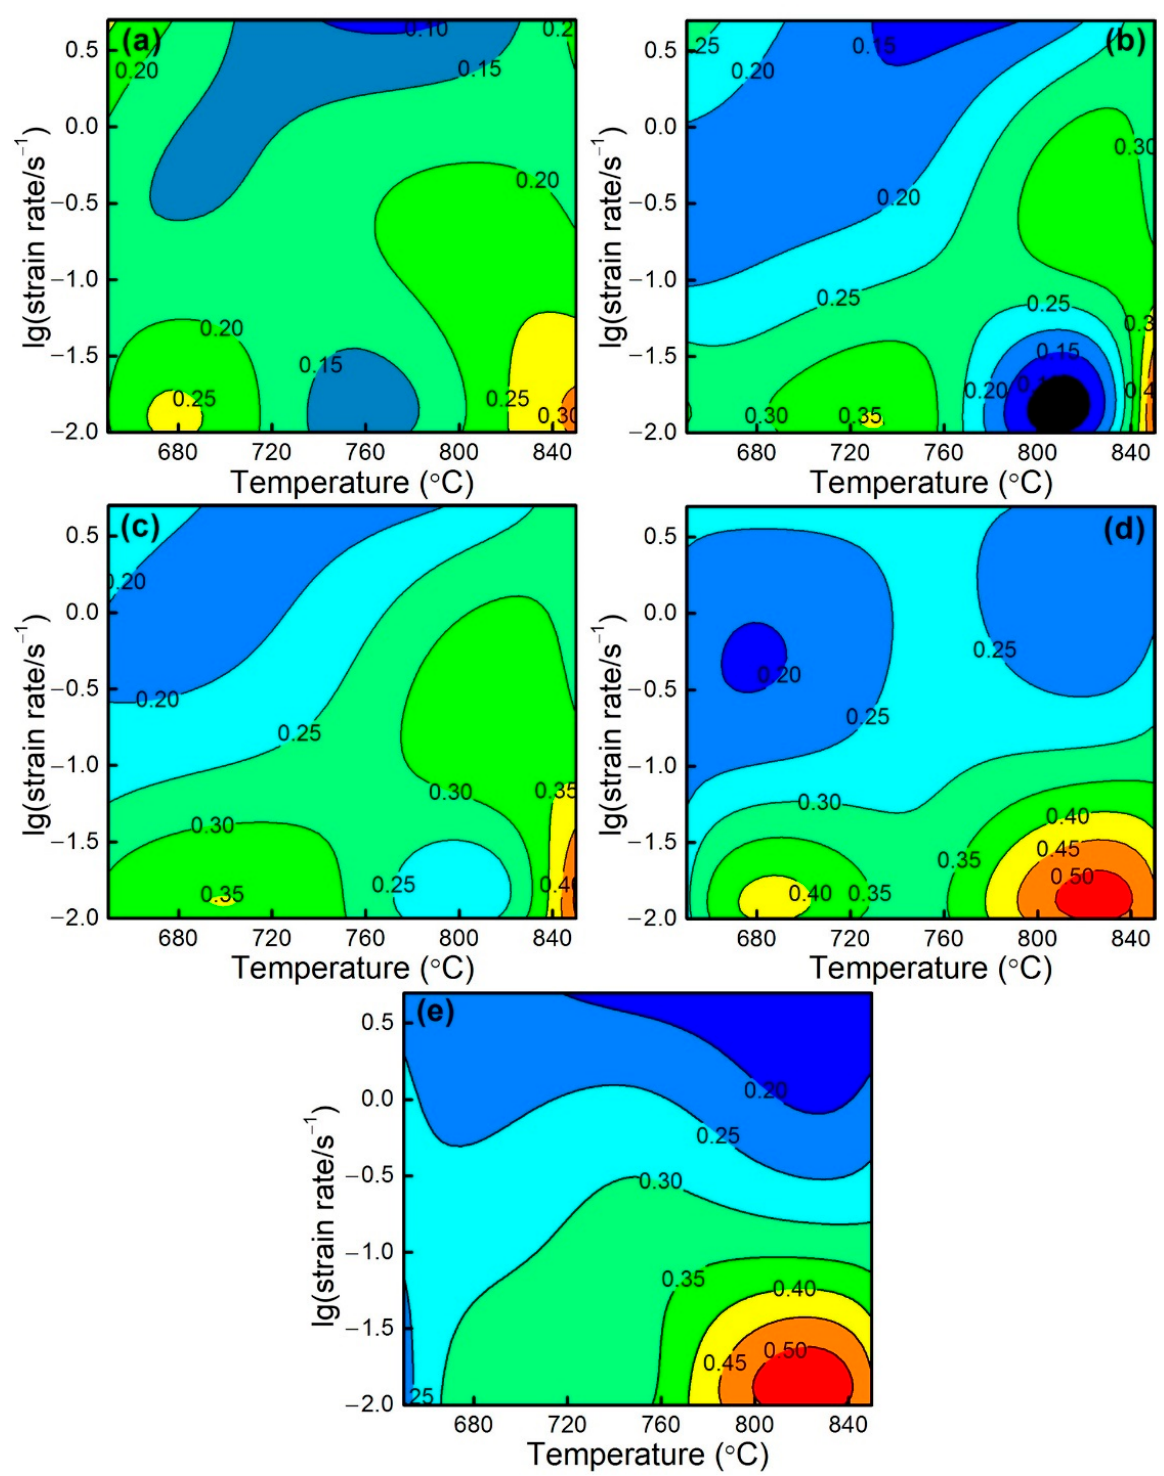
Figure 8. Processing maps of ZnSnO 3 /Cu composites at a true strain of ( a ) 0.1, ( b ) 0.5, ( c ) 0.7, ( d ) 0.9, and ( e ) 0.95.